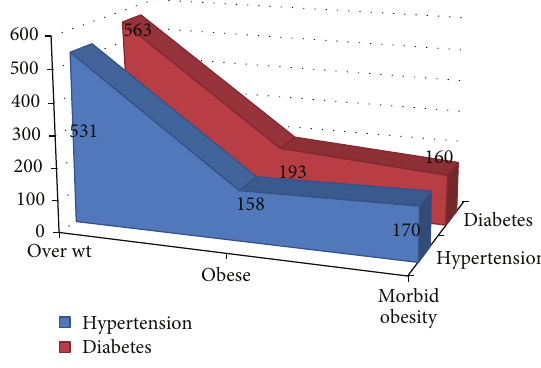
Figure 3: Description of obesity by hypertension and diabetes.